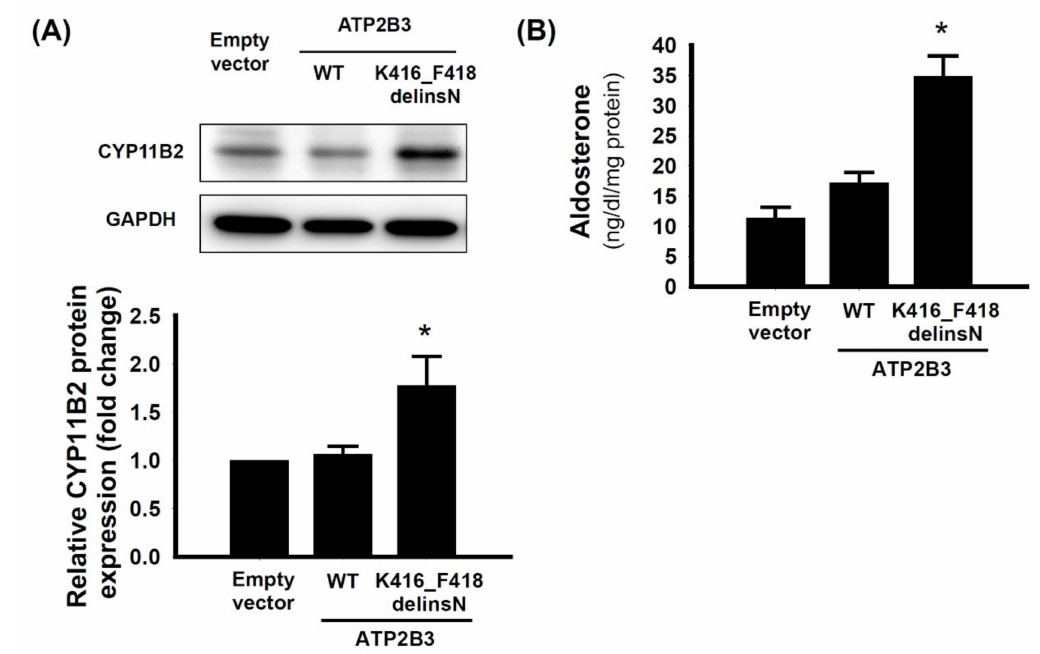
Figure 3. The CYP11B2 synthase and aldosterone production in the HAC 15 cells with transfected ATP2B3 K416_F418delinsN. The aldosterone synthase, CYP1B2, expression and supernatant aldosterone levels were analyzed at 72 h after plasmid transfection. ( A ) The cells transfected with ATP2B3 K416_F418delinsN had increased CYP11B2 protein expression in compared with the cells transfected with wild type cells; ( B ) The aldosterone levels of supernatant in the culture cells also increased in transfected group compared with the wild type cells. The data are presented as the means ± SD of three independent experiments in the transfected wild type and mutant cells. * p < 0.05 represented significant difference. The uncropped Western Blot image can be found in Figure